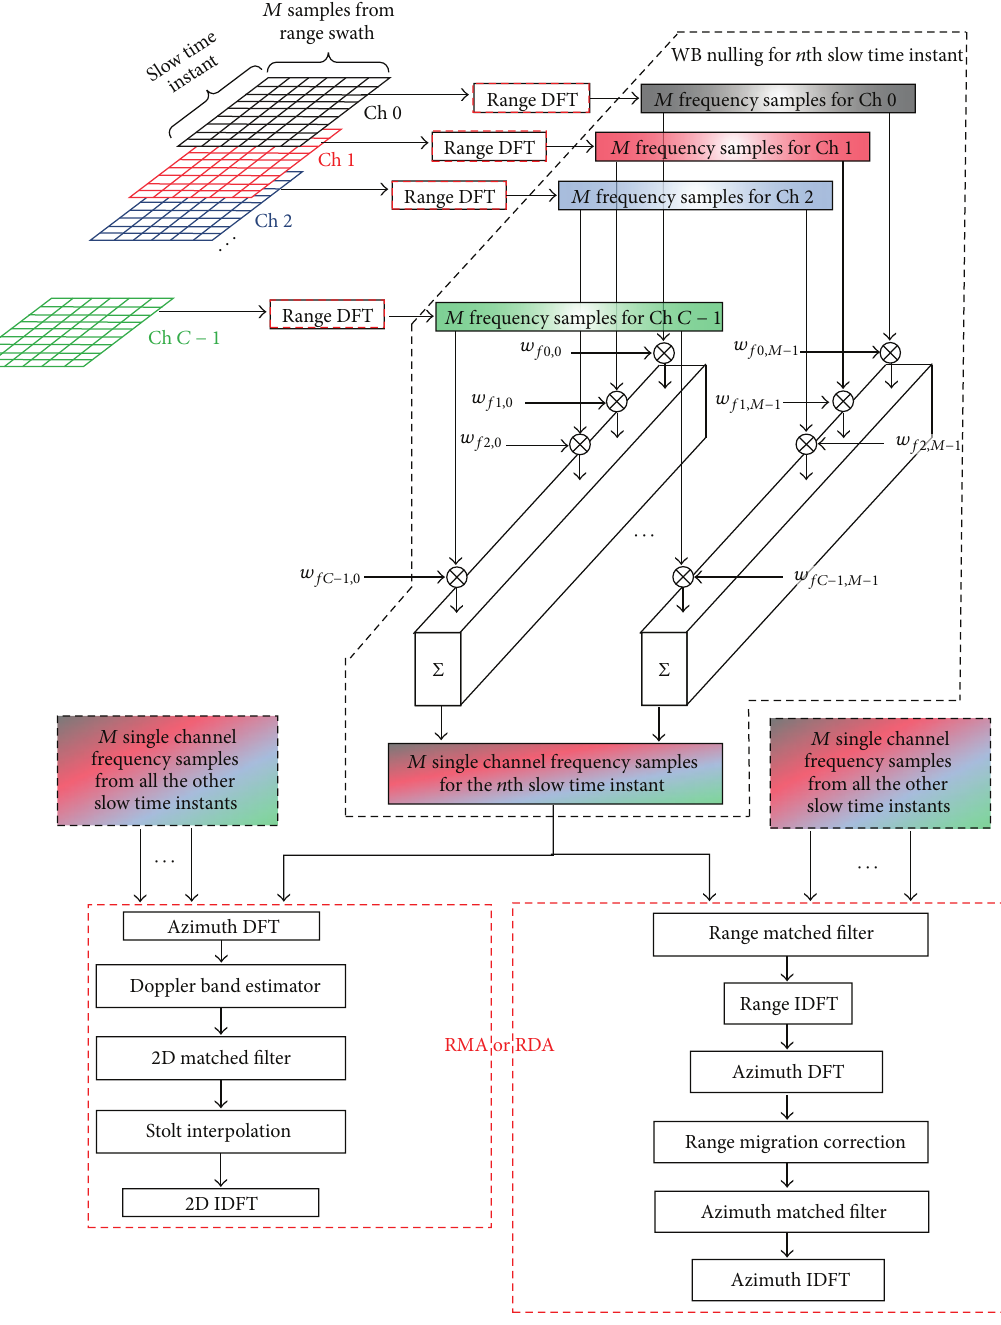
Figure 3: Integrated WB nulling and focusing